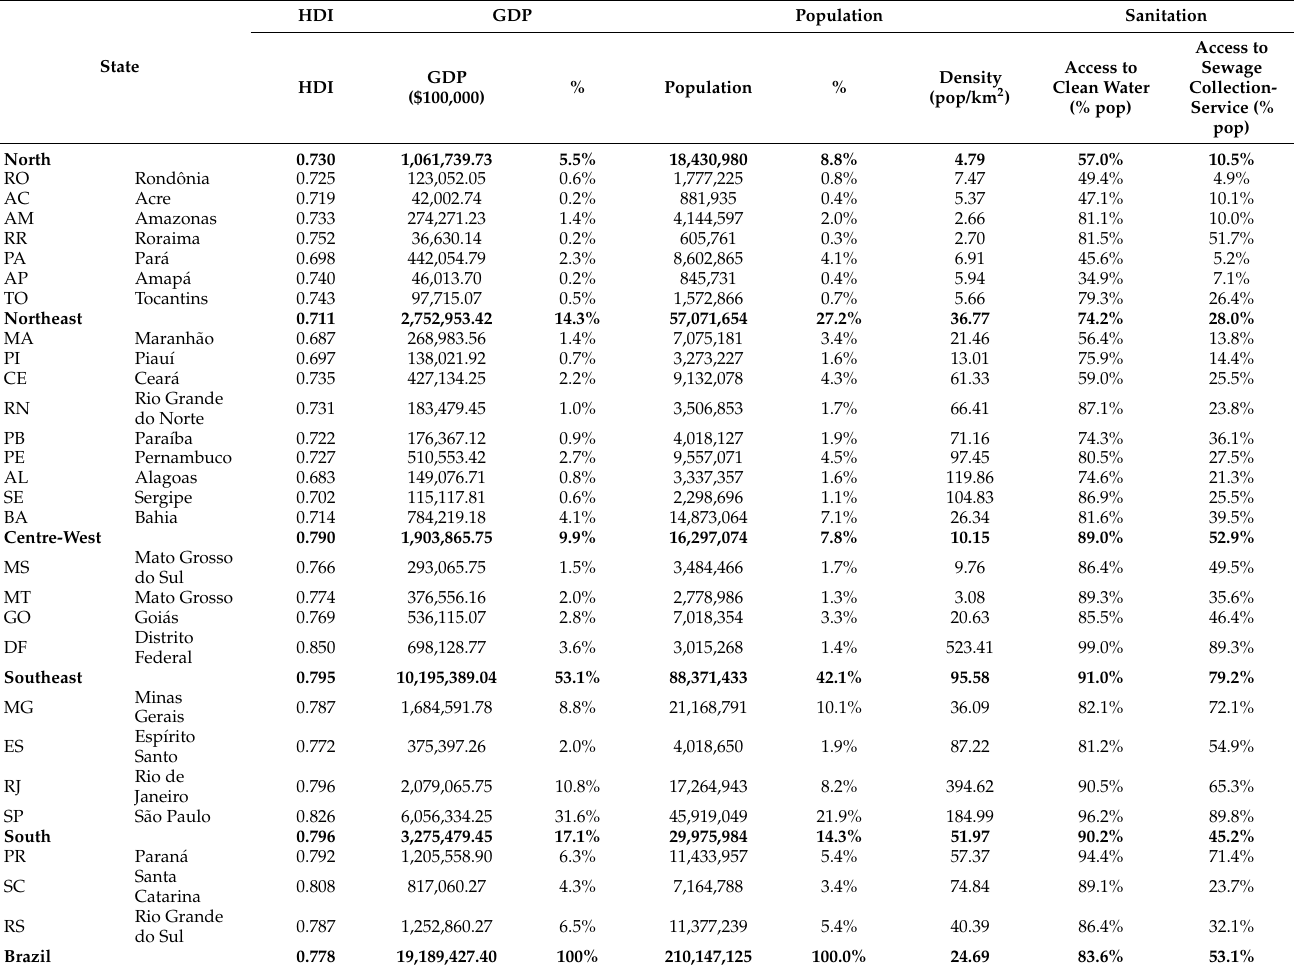
Table 1. Human development index (HDI), GDP, population, and sanitation indicators by region and